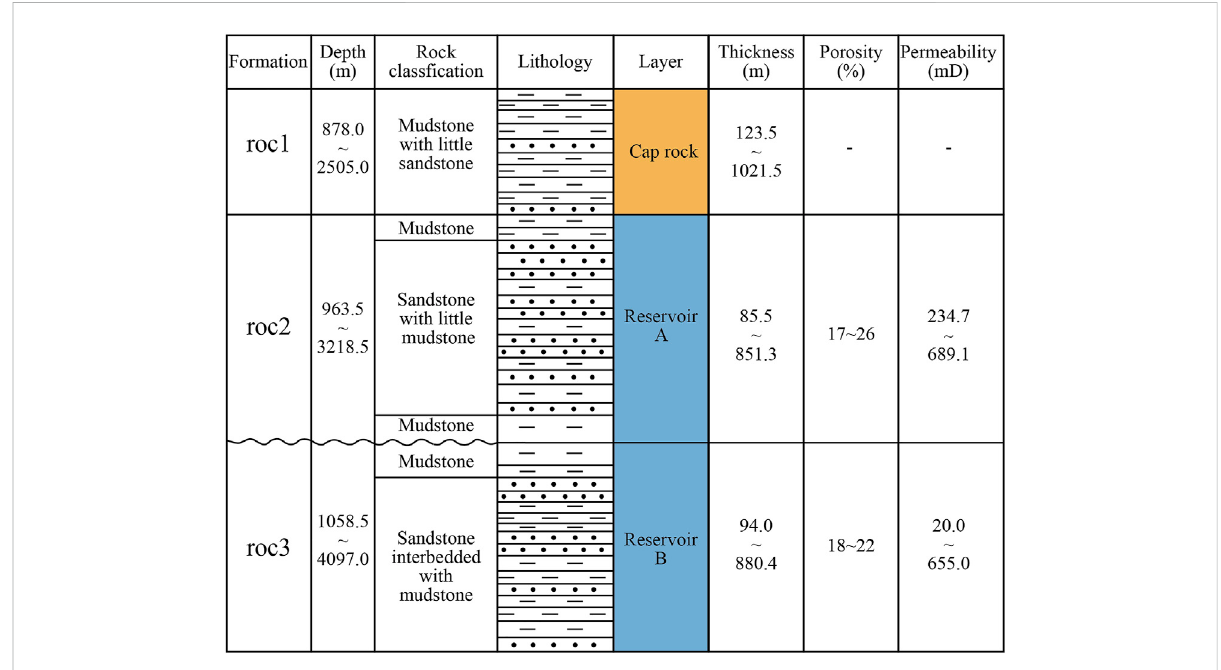
FIGURE 2 Overview of the study area formations (modi fi ed by Guo et al. (2014)).